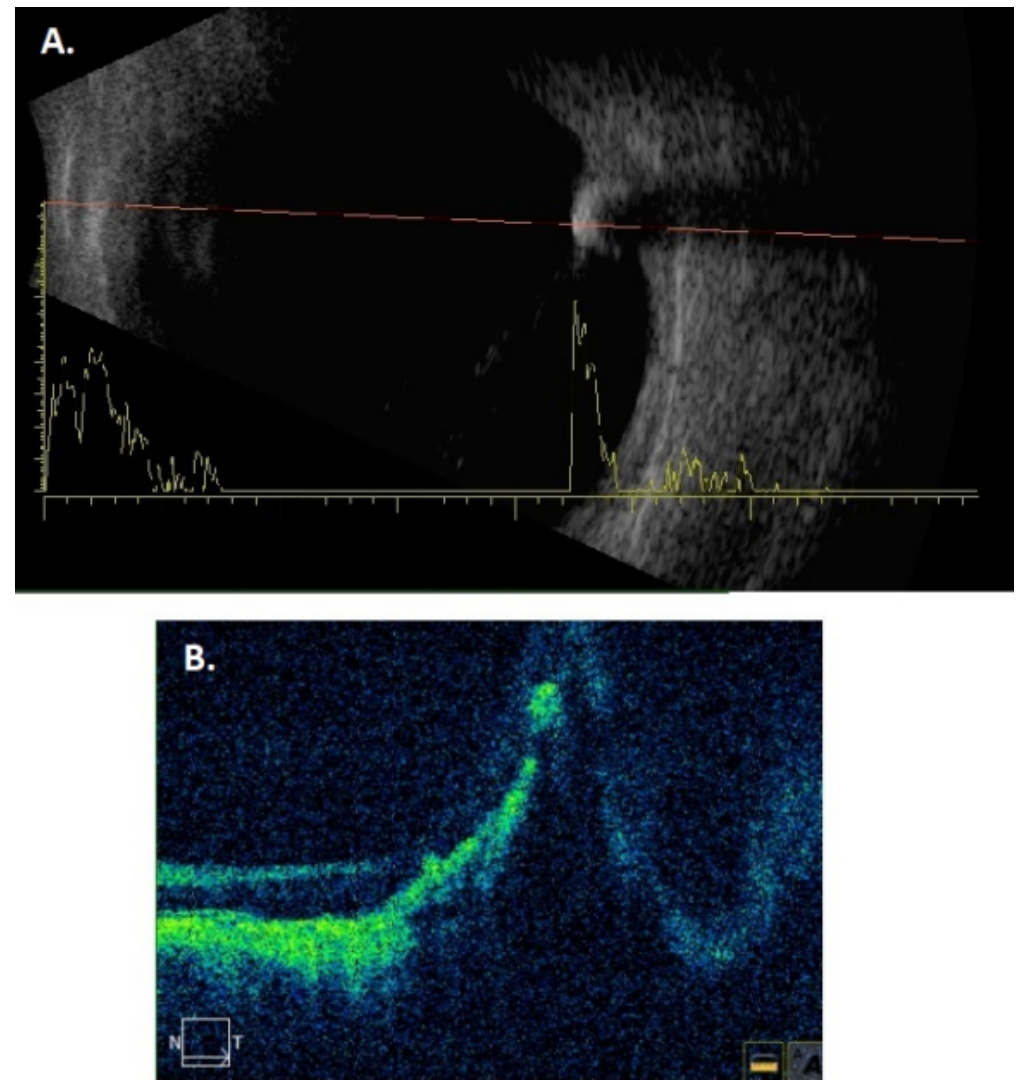
Figure 2: A. B-scan ultrasonography image shows a preretinal hyperechoic lesion with posterior shadowing. B. Optical coherence tomography image shows the preretinal localization of the foreign body with posterior shadowing. Both images do not disclose any choroidal